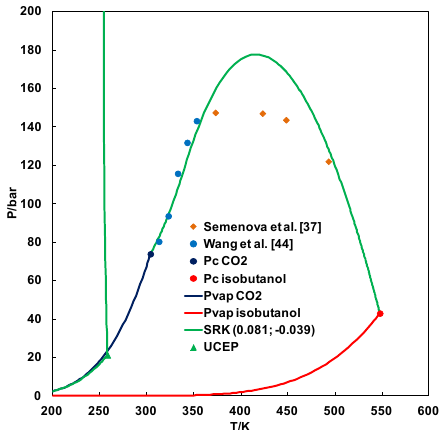
Figure 6. P−T fluid phase diagram of carbon dioxide + 2-methyl- 1-propanol binary system: blue full circle ( ● ) [42], orange full diamond ( ♦ ) [35], experimental critical curve; dark blue full circle ( ● ) and red full circle ( ● ), experimental critical points of pure components; dark blue and red solid lines (—,—), calculated vapor pressure curves of pure components; green full triangle ( ▲ ), UCEP and green solid lines ( ▬ ), critical curves and LLV line respectively calculated by SRK/ ( k l = 12